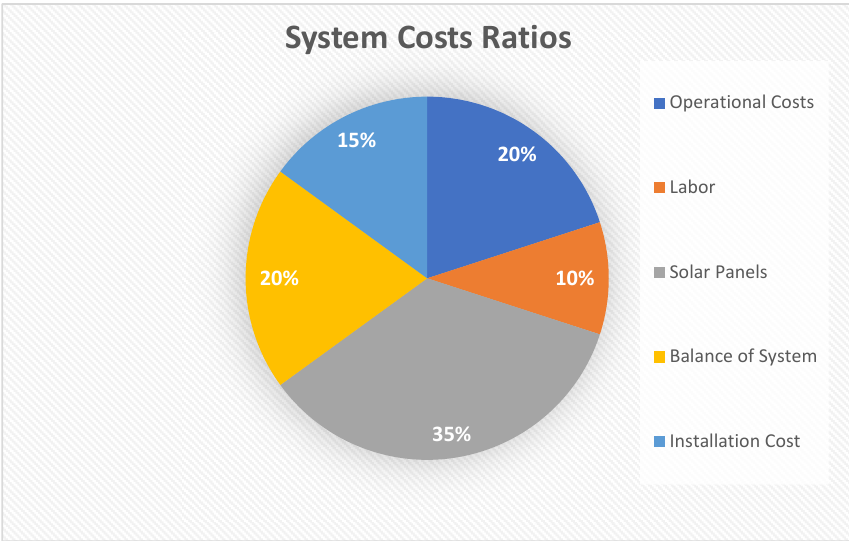
Figure 4. A 20-panel or 4500 W rooftop photovoltaic (PV) system cost breakdown.